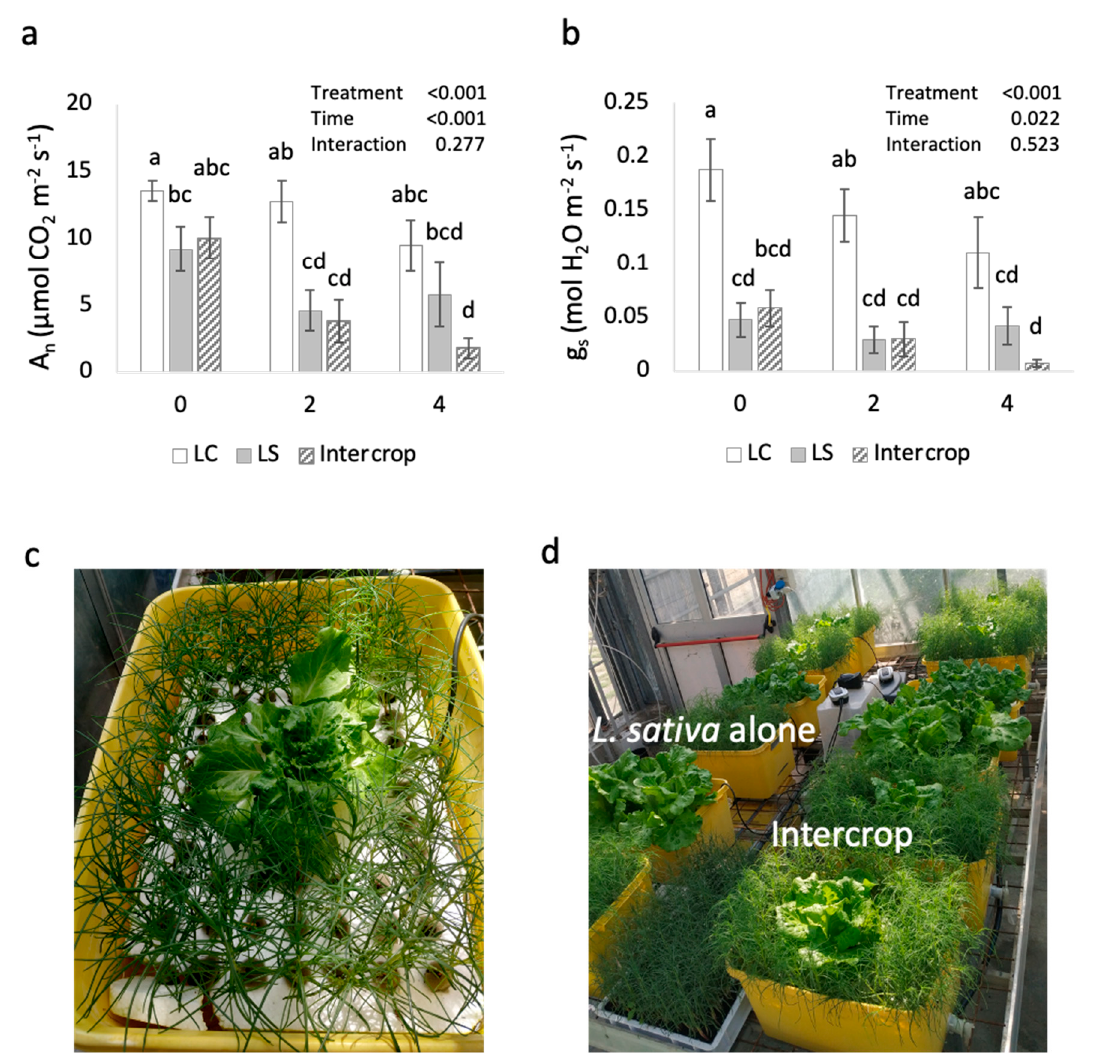
Figure 2. Gas exchange parameters, carbon assimilation rate ( a ) and stomatal conductance rate ( b ), at three time points (0, 2 and 4 weeks) and visual observations of intercropped L. sativa with S. soda at 1 week ( c ) and 4 weeks ( d ). Columns represent the mean of n = 6 with SEM. Different lowercase letters indicate significant differences between treatment groups over time ( p < 0.05) based on a two-way ANOVA and a post-hoc Tukey HSD. Table 3. Physiological parameters investigated in L. sativa (Time 0, 2 and 4) and S. soda (Time 4). Two-way ANOVA Parameters